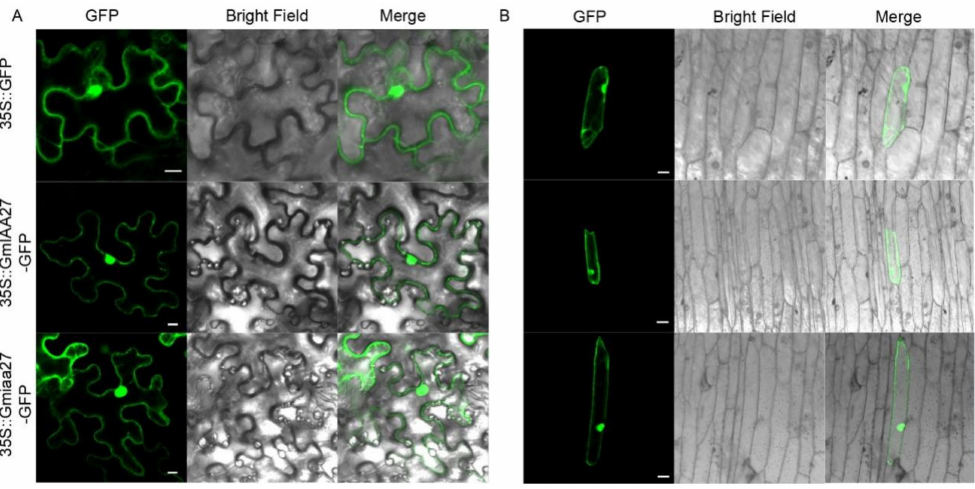
Figure 6. Subcellular localization of GmIAA27. ( A ) Subcellular location of 35S::GFP and 35S::GmIAA27/Gmiaa27-GFP in tobacco leaf cells. Bar, 10 µ m. ( B ) Subcellular location of